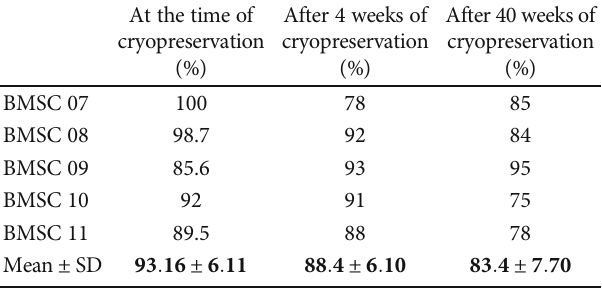
Table 7: Viability evaluation of the cryopreserved lots of BMSCs. At the time